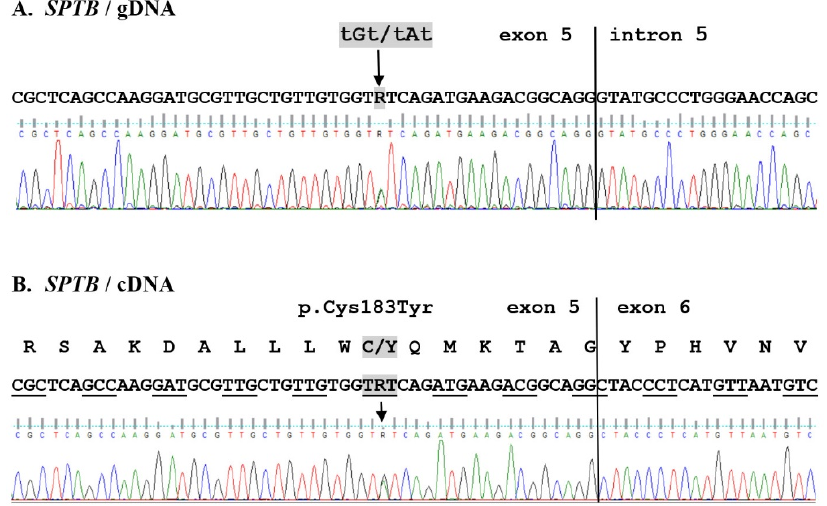
Figure 1. New SPTB mutation associated with hereditary spherocytosis. Fragment of sequencing traces of the SPTB gene in an affected patient (J42). Both gDNA and cDNA sequence analysis revealed a heterozygous substitution tGt/tAt in both affected patients, causing the missense mutation (p.C183Y).